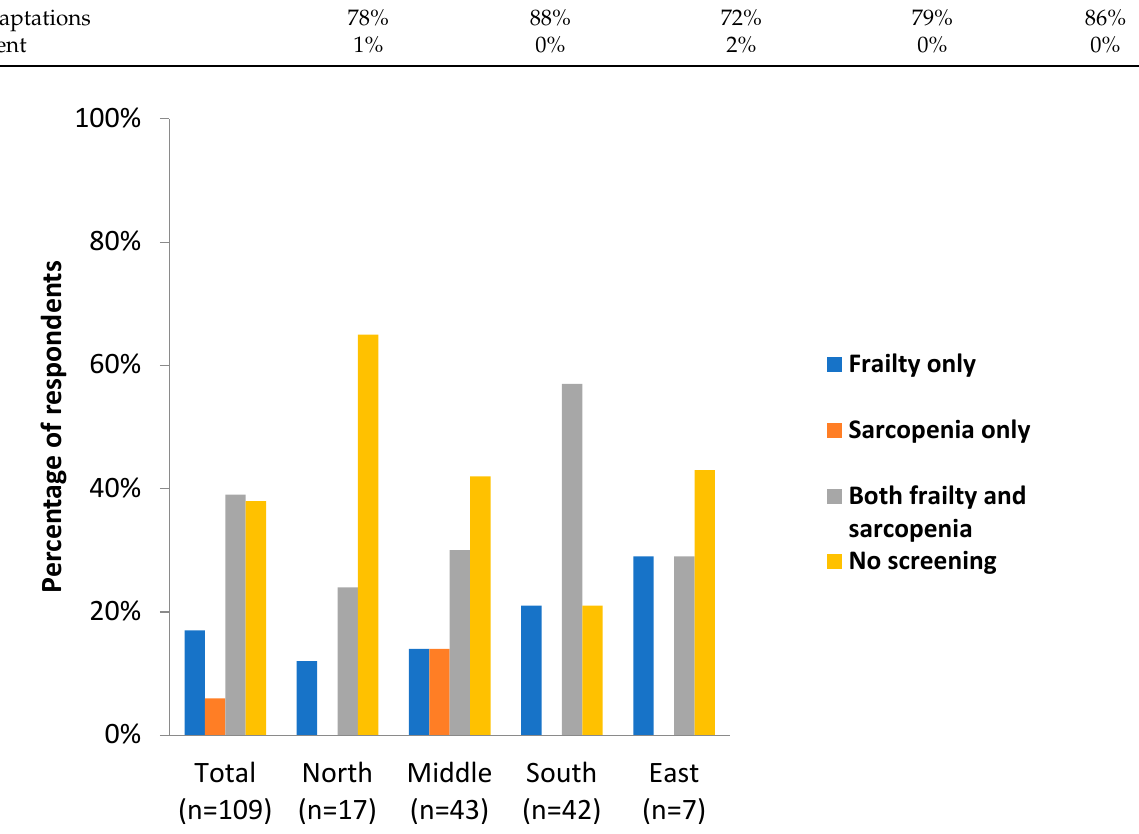
Figure 2. Screening for frailty and sarcopenia in different geographical areas in Europe.